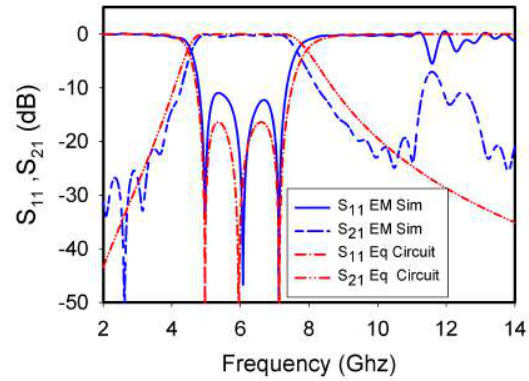
Figure 2: Electrical response of the conventionnel UWB parallel coupled bandpass filter